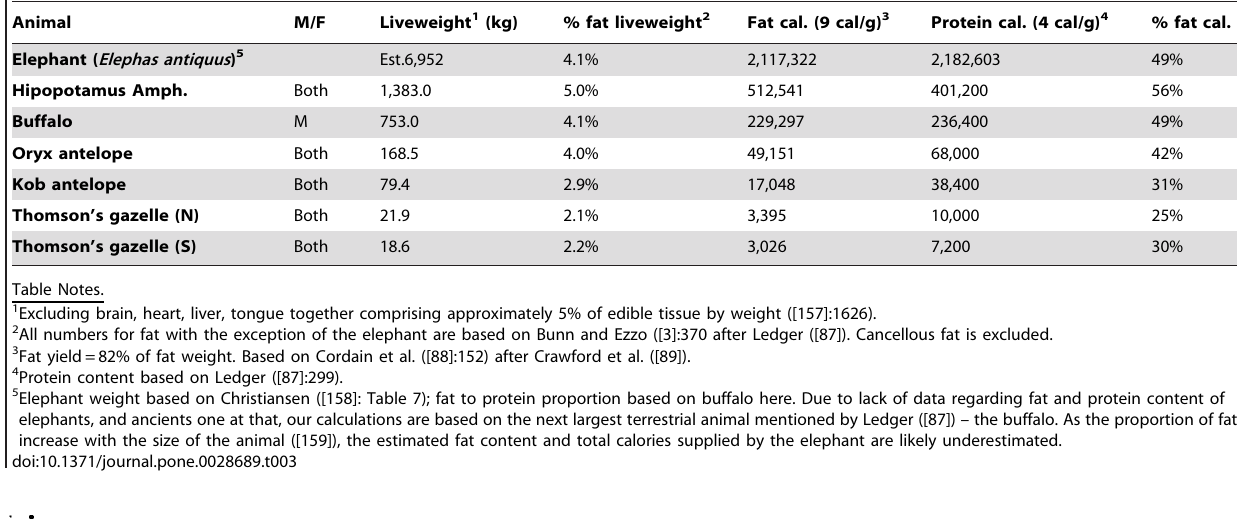
Table 3. Caloric protein and fat contribution of representative animals (and see Table S1).